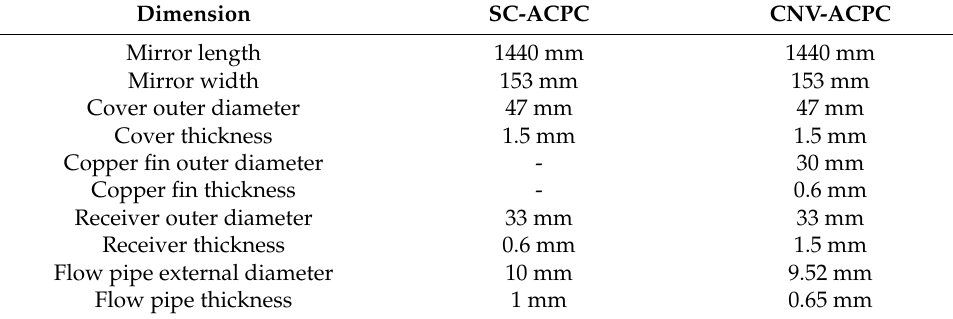
Table 1. Dimensions of the examined